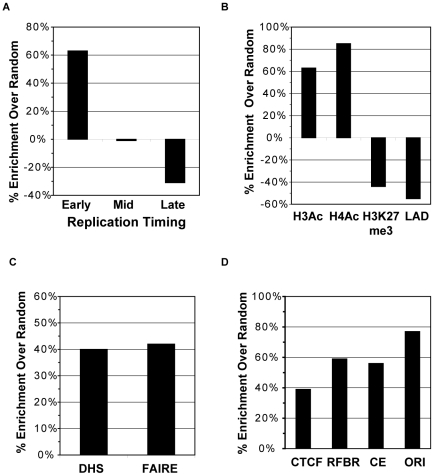
SARs are enriched in euchromatic regions and overlap functional elements.Percent enrichment (or depletion) of SARs in (A) early, mid, or late replicating regions of the genome, and (B) acetylated histones H3 and H4, trimethylation of histone H3K27, or Lamin B1 associated domains in comparison to a randomized data set. Enrichment of SARs that overlap (C) DNAse I hypersensitive sites (DHS) and formaldehyde-assisted isolation of regulator elements (FAIRE) as well as (D) CTCF insulator binding sites, regulatory factor binding sites (RFBR), conserved sequence element (CE), and origins of replication (ORIs), as compared to a randomized data set.